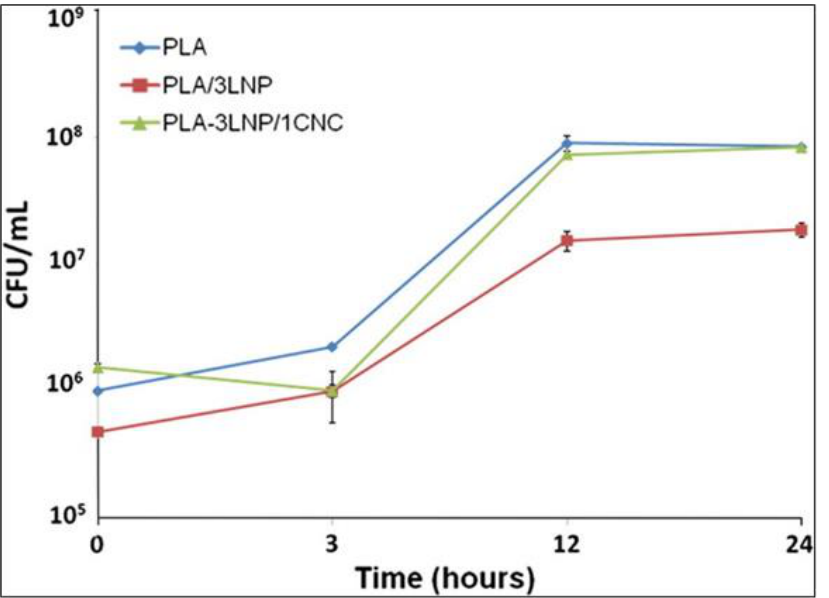
Figure 13. Antibacterial activity of different films based on neat PLA, PLA film with 3 wt.% of lignin nanoparticles (PLA-3LNP), PLA ternary system containing both cellulose nanocrystals (1 wt.%) and lignin nanoparticles (3 wt.%) (PLA-3LNP/1CNC), on the multiplication of tomato plant pathogenic bacteria Pseudomonas syringae pv. tomato (Pst) (CFBP 1323) 1 × 106 CFU/mL. Reproduced from ref. [120] with permission from Elsevier. 2016